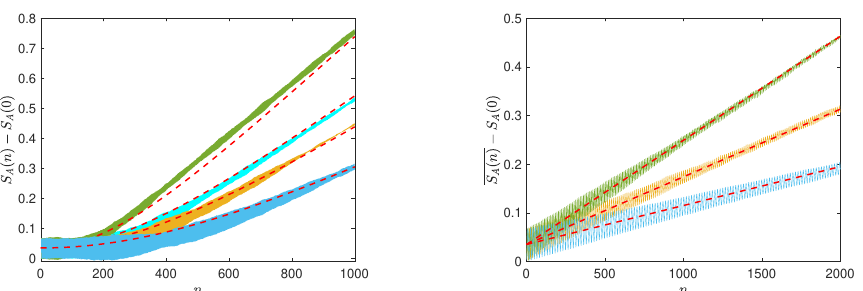
Figure 26: Left: Entanglement entropy evolution in the heating phase near the excep- tional point. The red dashed lines are fitting with Eq.(B.5) by choosing different λ , L = 0.035. From top to bottom, we choose ∆ T / l = 5 × 10 − 5 , and fixing c = 1 and c 0 eff 1 × 10 − 5 , 5 × 10 − 6 , and 1 × 10 − 6 , respectively. Right: Entanglement entropy evolu- tion in the heating phase near the trivial point. The red dashed lines are fitting with = 0.035. From top to bottom, we Eq.(B.6) by choosing different λ , and fixing c L 0 = 0.4, 0.42, and 0.44, respectively. Other parameters are the same choose ∆ T / l eff as those in